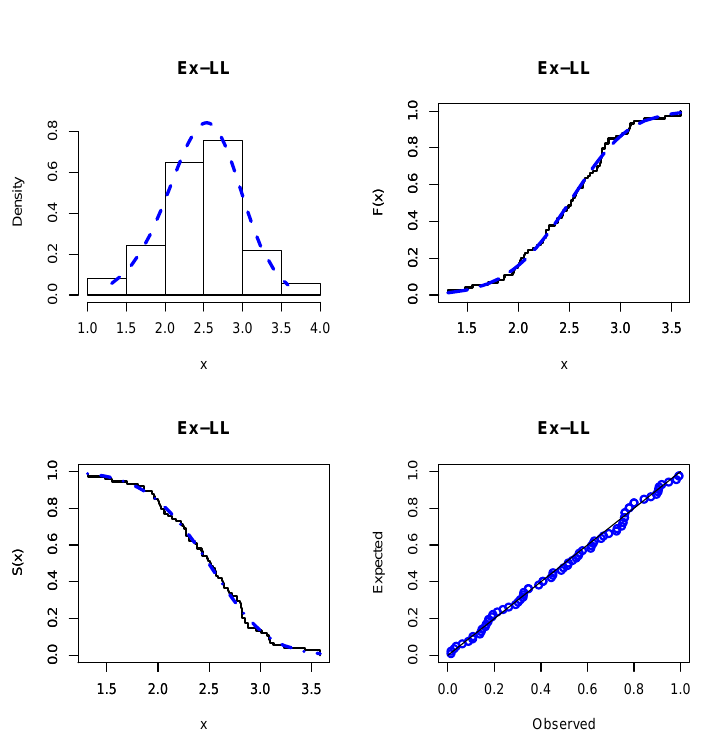
Figure 5. Histogram of data set I along with the fitted functions of the Ex-LL